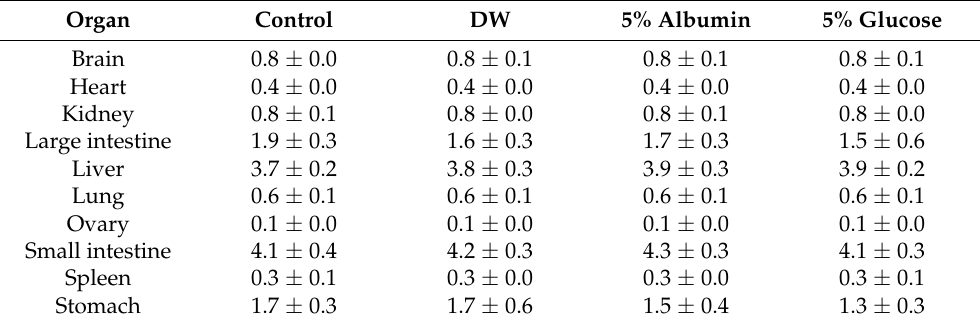
Figure 9. Changes in ( A ) body weight gains, ( B ) food intake, and ( C ) water consumption of rats after oral administration of ZnO NPs (100 mg/kg) interacted with DW, albumin, or glucose for 14 consecutive days. Rats administered an equivalent volume of DW without ZnO NPs were used as controls. No significant differences among untreated control and ZnO interacted with DW, albumin, or glucose were found ( p > 0.05). Table 2. Organo-somatic indices of rats after oral administration of ZnO NPs (100 mg/kg) interacted with DW, albumin, or glucose for 14 consecutive days.